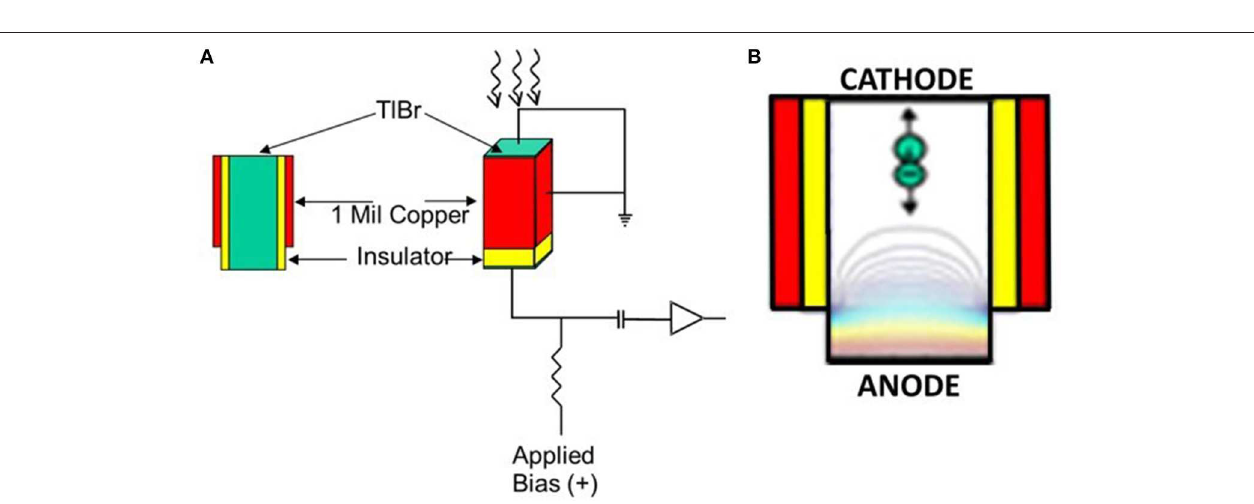
FIGURE 5 | (A) TlBr CFG detector configuration. (B) CFG operating